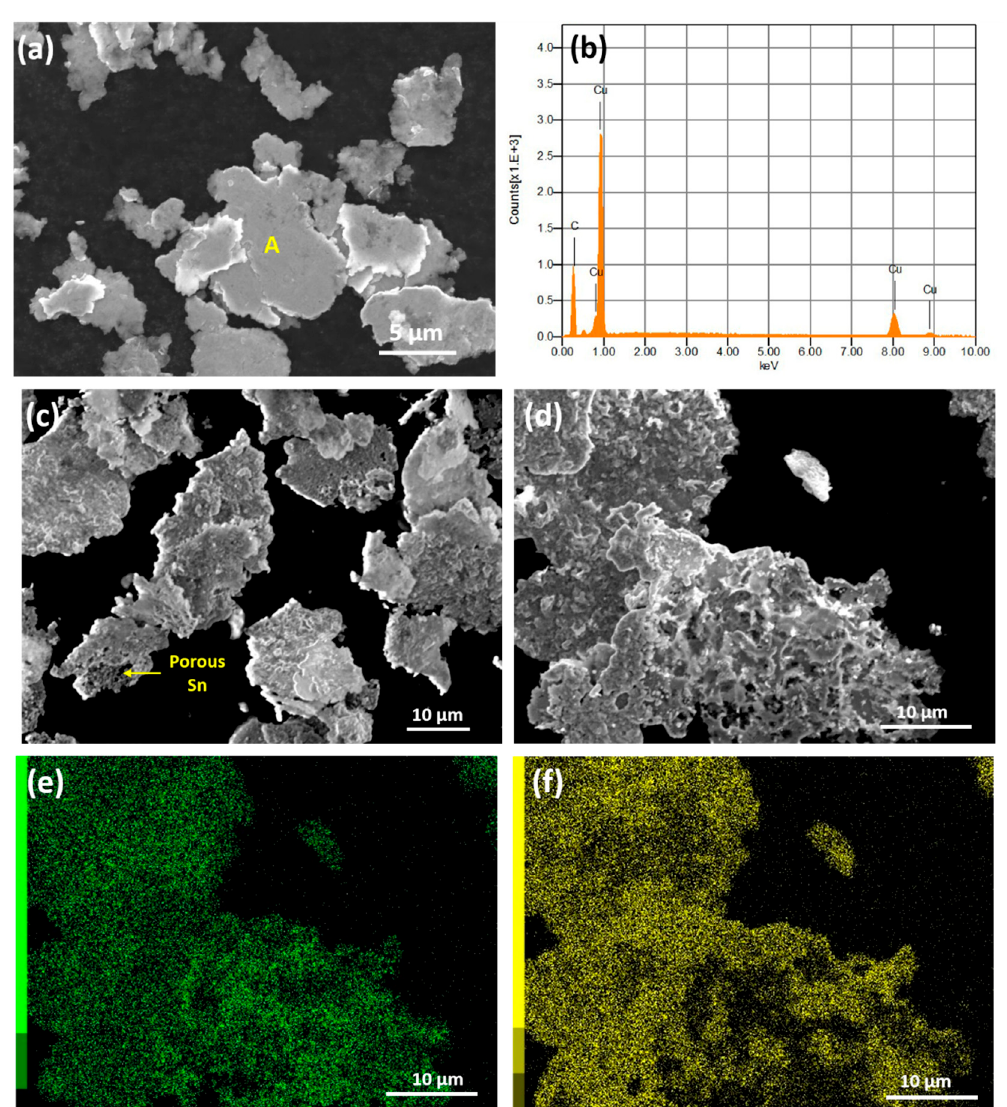
Figure 2. SEM analysis of powders ( a ) Cu-MWCNT composite; ( b ) energy dispersive spectrometer (EDS) analysis of point A; ( c ) and ( d ) Sn coated Cu-MWCNT composite; ( e ) and ( f ) EDS elemental mapping of Cu and Sn,